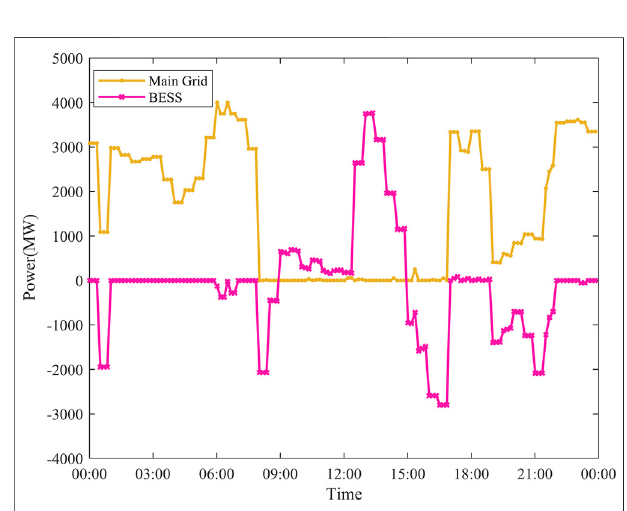
FIGURE 6 | Dispatch scheme for energy based on RMPC